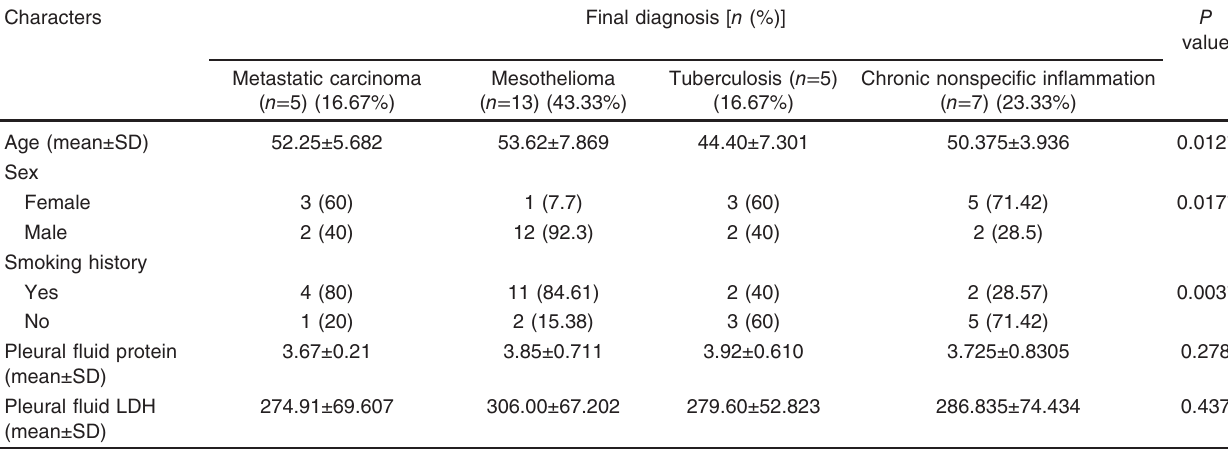
Table 1 Patient characteristics in relation to final diagnosis (number = 30 patients) Characters Final diagnosis [ n (%)] P